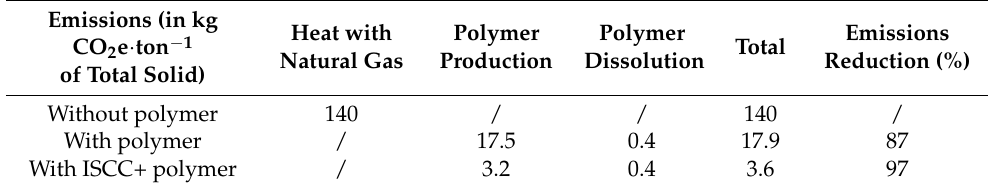
Table 1. Comparison of CO 2 emissions during dewatering according 3 cases: without polymer, with fossil-based polymer and with ISCC+ certified